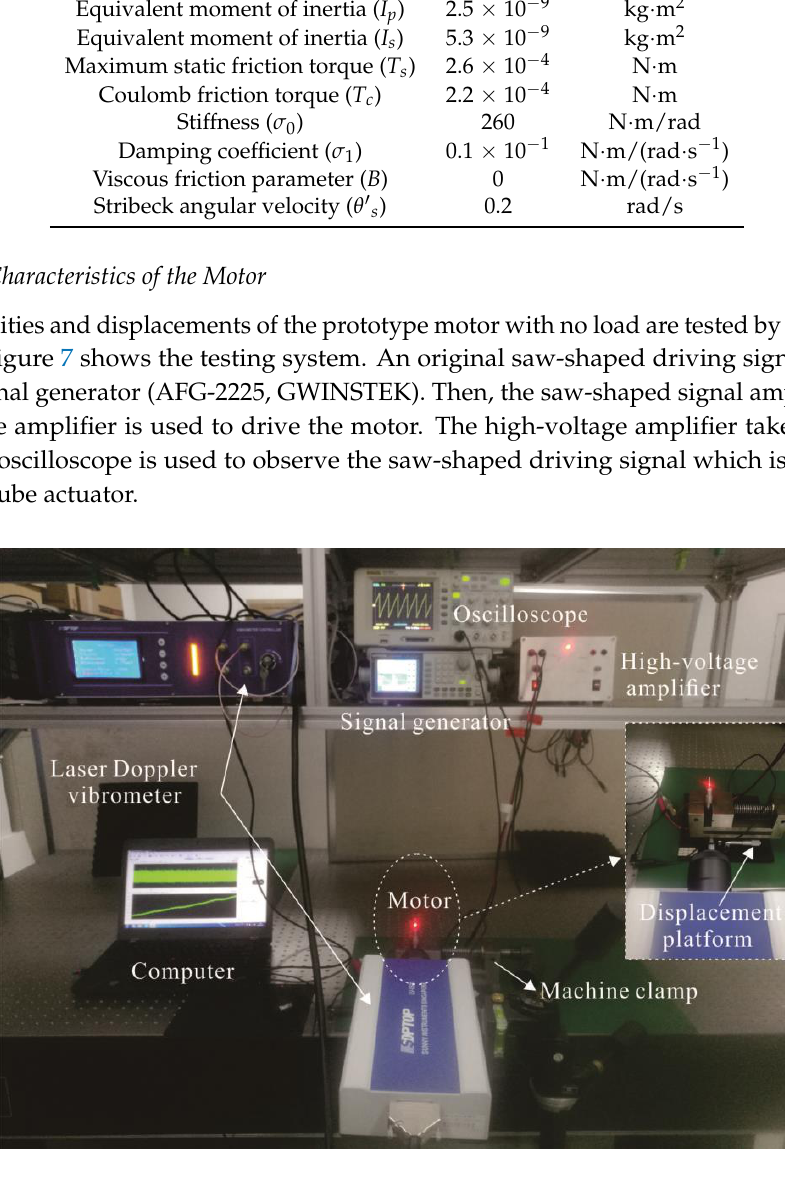
Figure 7. The testing system of the rotary motor.